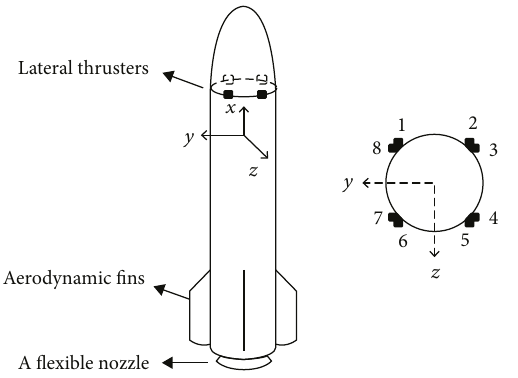
Figure 1: The diagram of the layout of lateral thrusters.